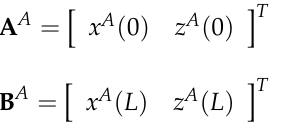
Figure 1. Cable sag model in frame